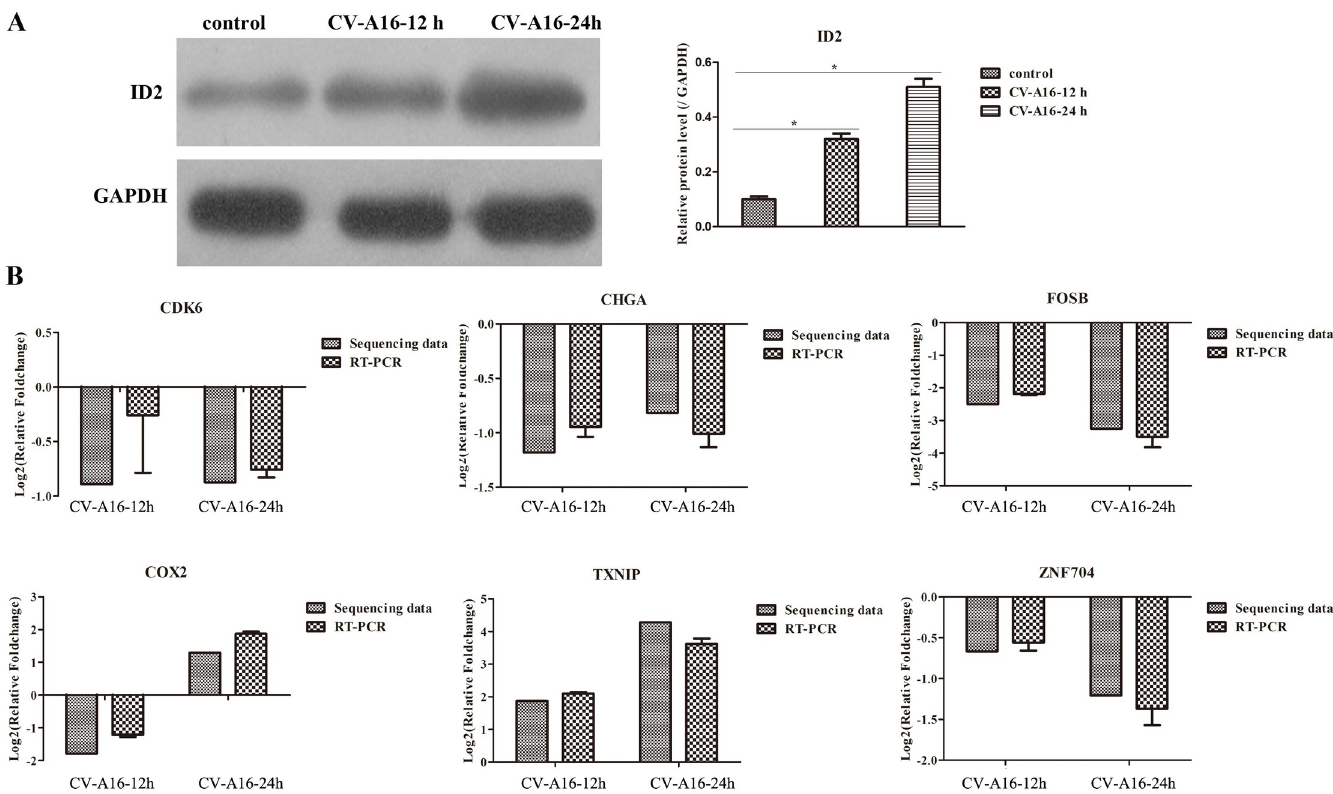
Fig 5. (A) The protein levels of ID2 were checked by WB in SH-SY5Y cells with CV-A16 infection. (B) A total of 6 differentially expressed genes were randomly selected for qRT-PCR validation.